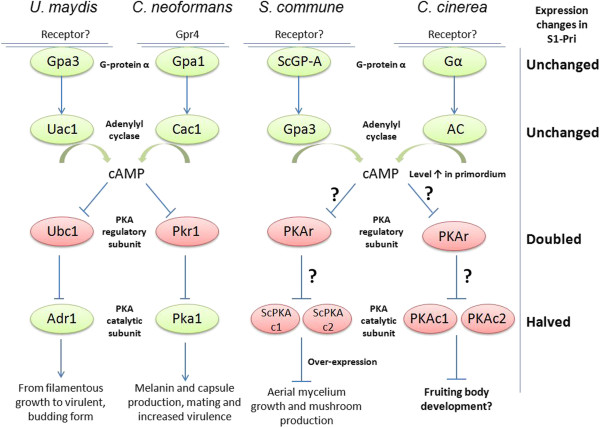
The cAMP signaling pathway and morphogenesis in four selected basidiomycetes. The cAMP signaling pathway in four basidiomycetes Ustilago maydis, Cryptococcus neoformans, Schizophyllum commune and C. cinerea (adapted from Lengeler et al., 2000 and Palmer and Horton, 2006). The G-protein-coupled receptor had only been identified in C. neoformans. G-protein α: “cAMP-type” alpha subunit of the heterotrimeric G-protein. PKA: protein kinase A. Proteins with activating functions are colored in green, and proteins with known/putative repressive functions are colored in red.